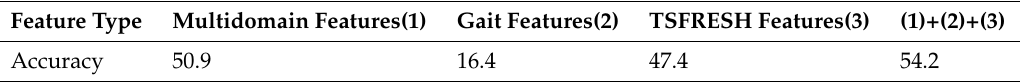
Table 9. Classification accuracy using different